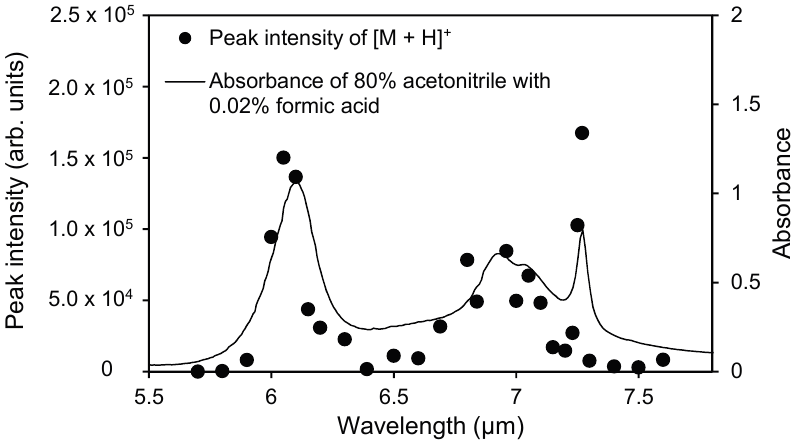
Figure 4. Wavelength dependence of the peak intensity of [M + H] + of angiotensin II from an 80% acetonitrile aqueous solution and the IR absorption spectrum of the 80% acetonitrile aqueous solution. The electric potential of the frit and the capillary temperature were set to 2.5 kV and 270 °C, respectively